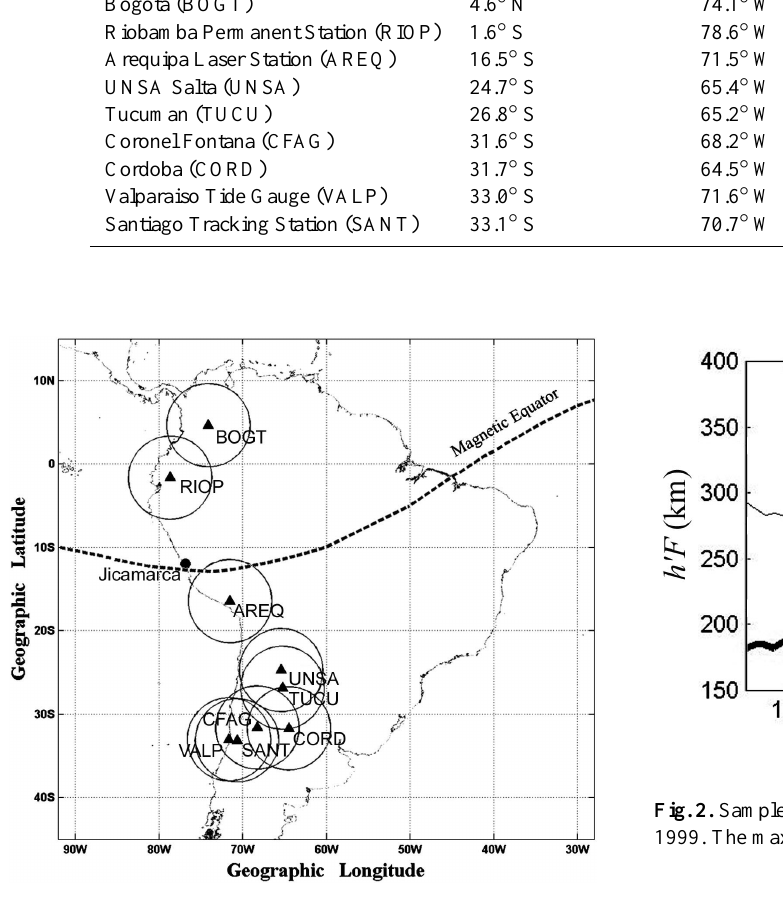
Fig. 1. Map of a digisonde and a chain of nine GPS receivers. The solid dot represents the Jicamarca digiosonde, while the triangles symbolize the nine GPS stations on the west side of South America. The circles at each GPS site give the field-of-view for a 400-km intersection height at an elevation angle at 30 ◦ .